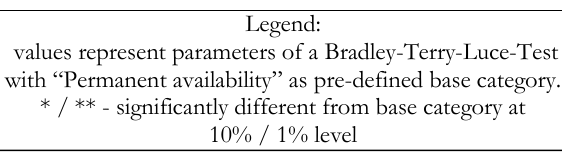
Figure 4. Pairwise